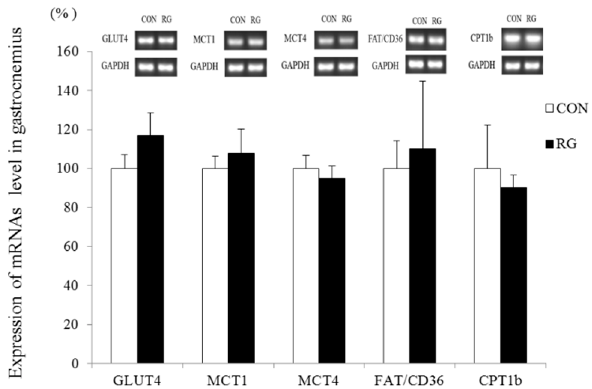
Figure 3. Reverse transcription PCR analysis of GLUT4 , MCT1 , MCT4 , FAT / CD36 , and CPT1b mRNA levels in the gastrocnemius after 2 weeks of red ginseng (RG) intake. Values are presented as the mean ± SE.